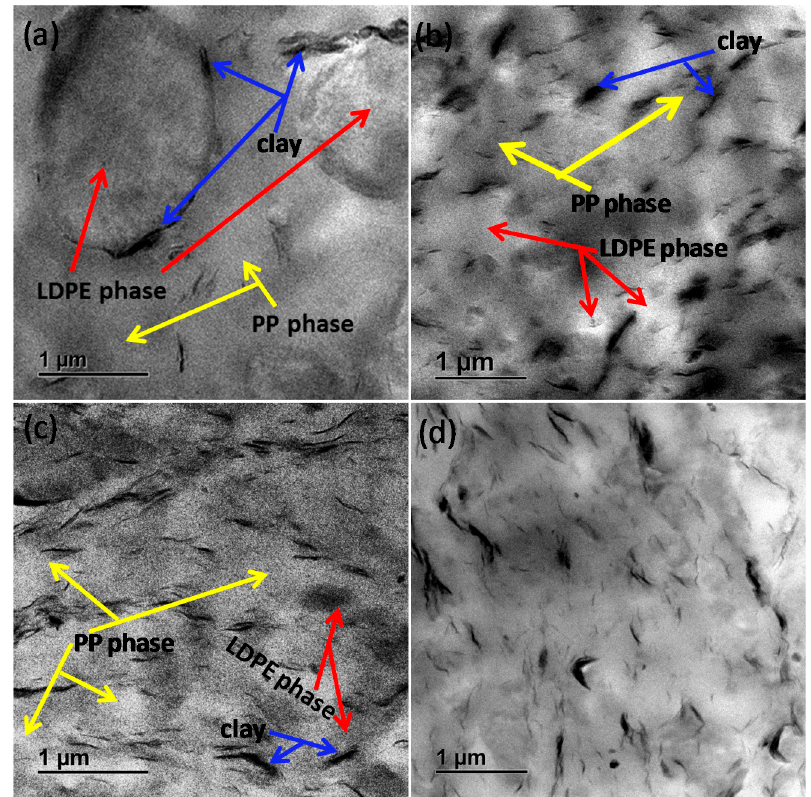
Figure 2. TEM images of PP/LDPE/PP- g -MA/PE- g -MA/clay: ( a ) 80/20/0/0/4, ( b ) 80/20/5/0/4, ( c ) 80/20/0/5/4, and ( d ) 80/20/5/5/4. The arrows indicate PP phase, LDPE phase, and nanoclay.